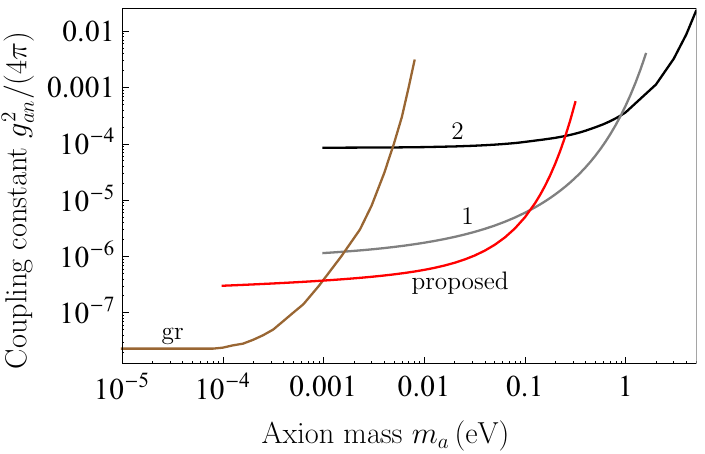
Figure 10. The constraints on the coupling constant of axion to nucleon, which can be obtained from the proposed CANNEX test, are shown by the line “proposed” as a function of the axion mass. For comparison purposes, the lines 1, 2 and “gr” are reproduced from Figures 6 and 8, respectively. The regions above each line are excluded and below each line are